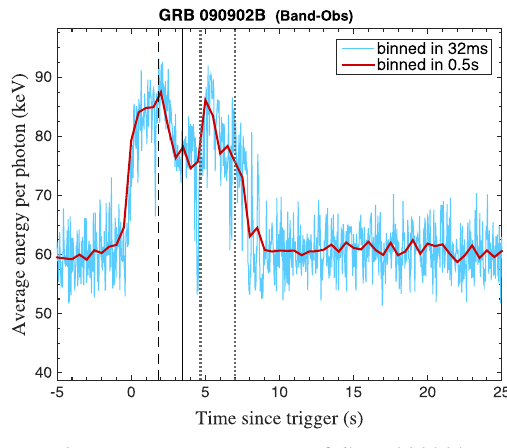
Fig. 12 The light curve and average energy curve of GRB 090902B in Band-Obs. The vertical solid lines refer to t obs /( 1 + z ) of Criterion 0 (the first main peak of the light curve) and the vertical dashed lines